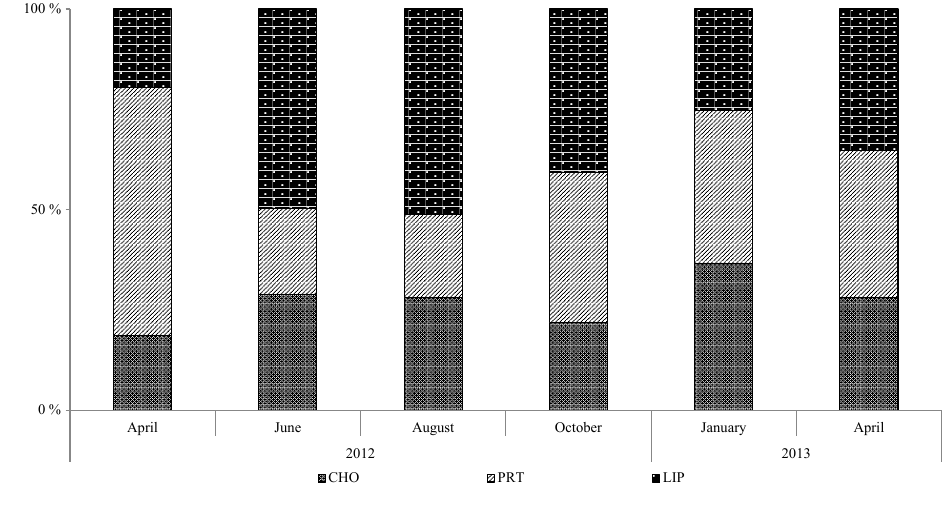
Figure 2. The seasonal variation in biochemical composition in Gwangyang